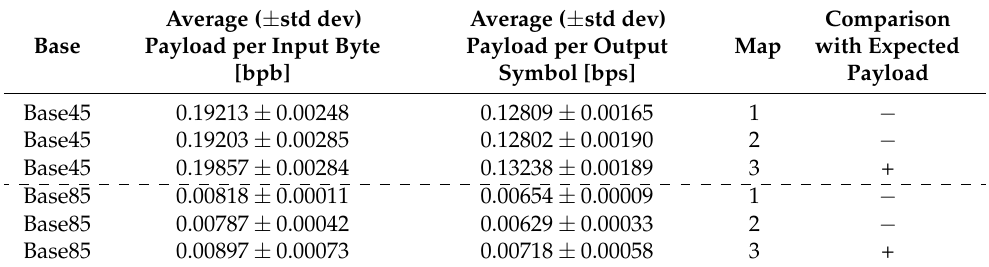
Table 7. Results of the Base45 and Base85 encodings applied to 28 compressed files (format .gz).